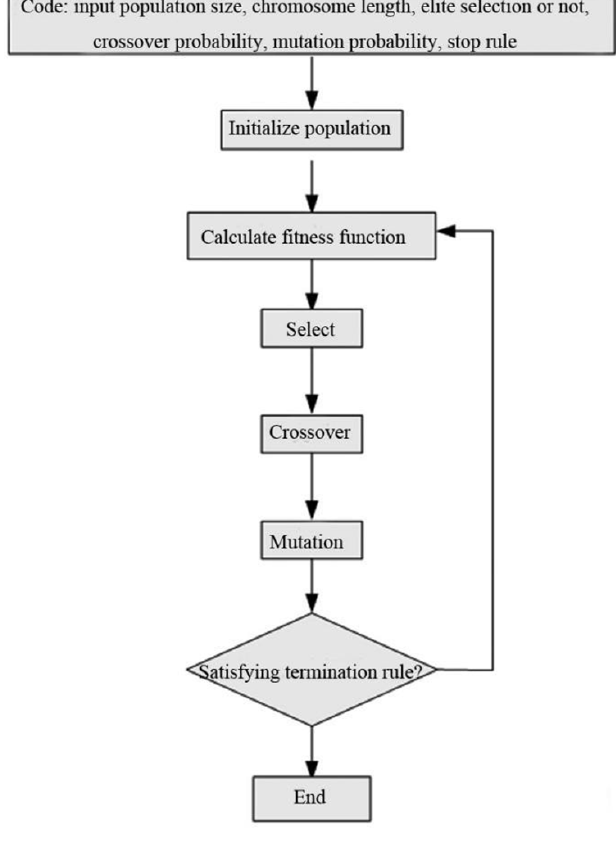
Fig. 2. Basic structure of genetic